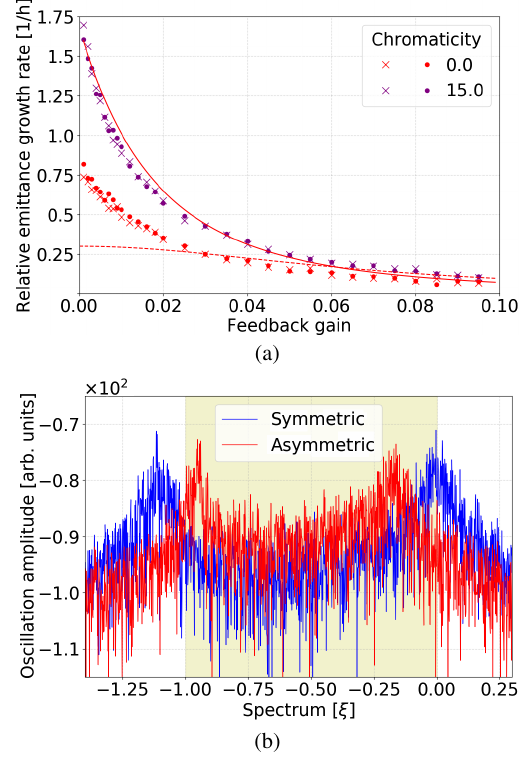
FIG. 5. Relative emittance growth rate as function of the feedback gain for different chromaticities (upper plot), for a configuration with two IPs and asymmetric phase advances between them. In one beam the phase advance from the first IP, say IP1, to the second, say IP2, is a multiple of 2 π . In the second beam the phase advance from the second IP2 to IP1 is also a multiple of 2 π . The numerical parameters for the simulations are listed in Table I. The lower plot shows the beam centroid oscillation spectrum shifted at the bare machine tune obtained with Fourier transform of the turn-by-turn beam position at the IP for the asymmetric configuration and the corresponding sym- metric configuration, i.e., in which the phase advances between IPs are all identical in both beams. The chromaticity for these simulations is set to 0 and the feedback gain to 5 × 10 − 3 . The incoherent spectrum, shaded in yellow, is unaffected by the phase advance between IPs.